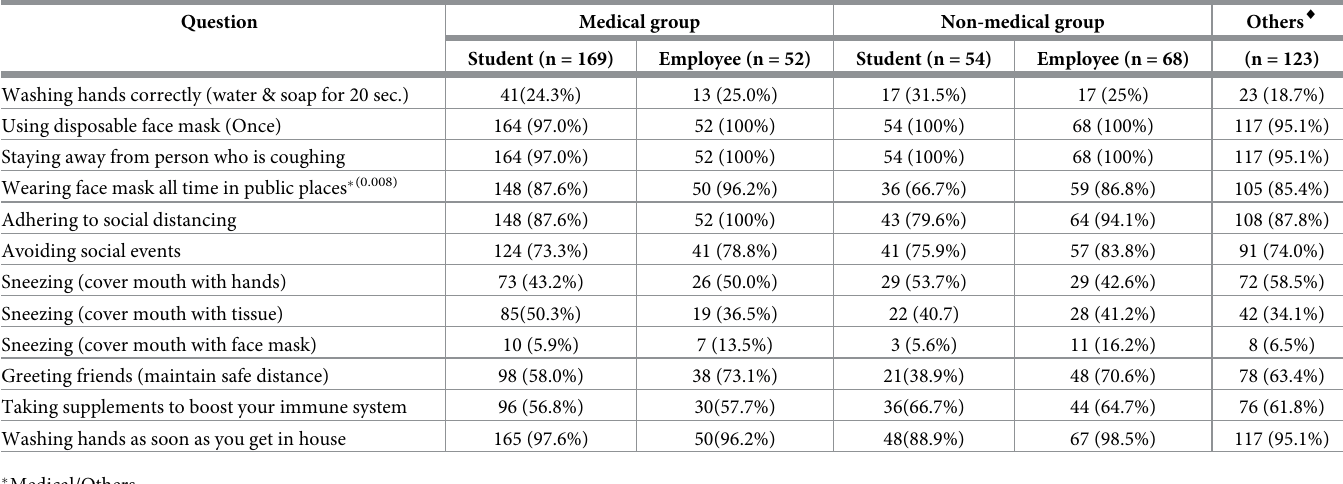
Table 5. Good practices followed by